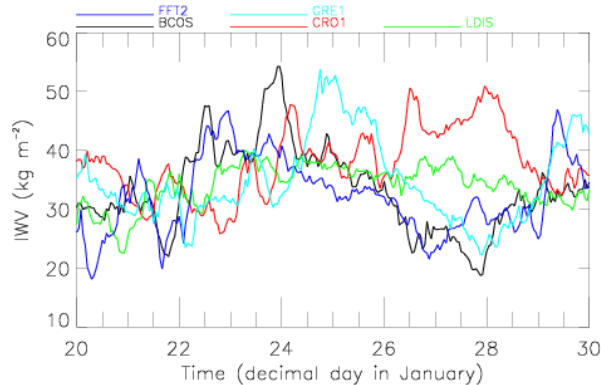
Figure 12. IWV time series observed from GNSS over each of the five sites between 20 and 30 January 2020.